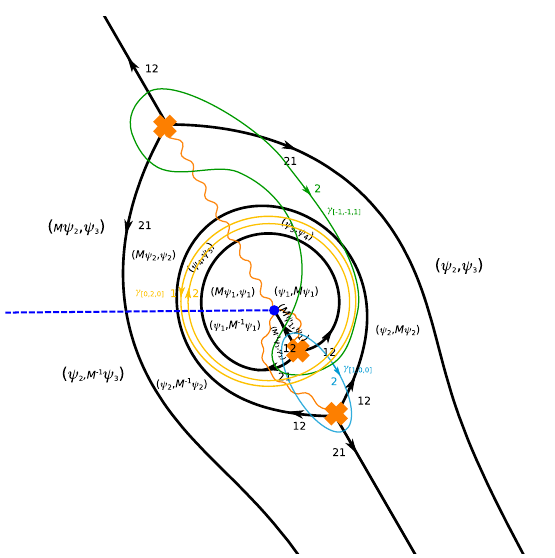
Figure 11 . W ϑ =0 at u = 2 , m = i / 10 , Λ = e − i π/ 6 . Decaying solutions are along R e − π i / 3 approaching e − π i / 3 ∞ , e − π i / 3 0 and e 2 π i / 3 ∞